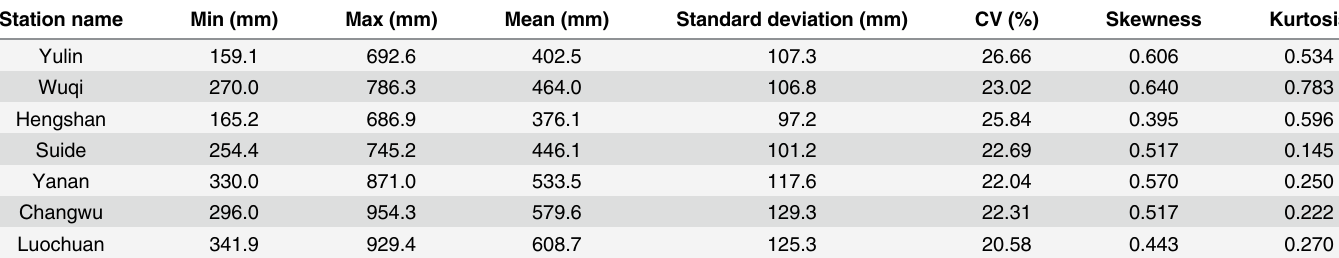
Table 4. Statistical parameters of annual precipitation time series for the seven synoptic stations during 1957 – 2012.